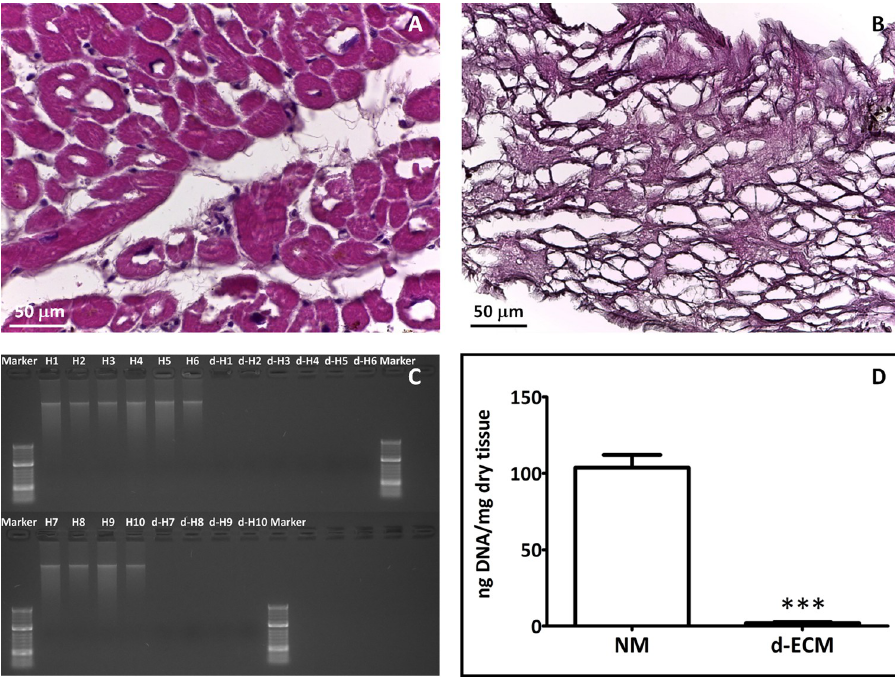
Fig 2. Evaluation of decellularization procedure effectiveness. Representative images of Hematoxylin and Eosin staining (HE) on cryosections of native myocardium (A) or of d-ECM (B). Scale bar length is 50 μ m. C: Agarose gel electrophoresis analysis of dsDNA isolated from native myocardium and d-ECM. D: Graphical representation showing a DNA content in native myocardium (NM) of 103.8 ± 8.34 and in d-ECM of 2.049 ± 0.7186 ng per mg of dry tissue. Each value expresses the mean of 10 samples (n = 10) ± SEM ( ��� p < 0.0001).